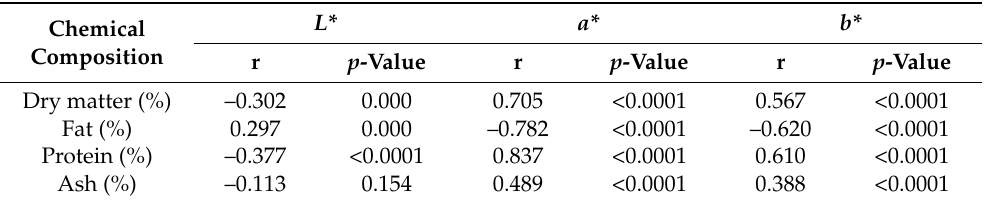
Table 1. Pearson correlation coefficients (r) for dry matter, fat, protein, and ash concentrations and the CIE coordinates L* , a* , and b*